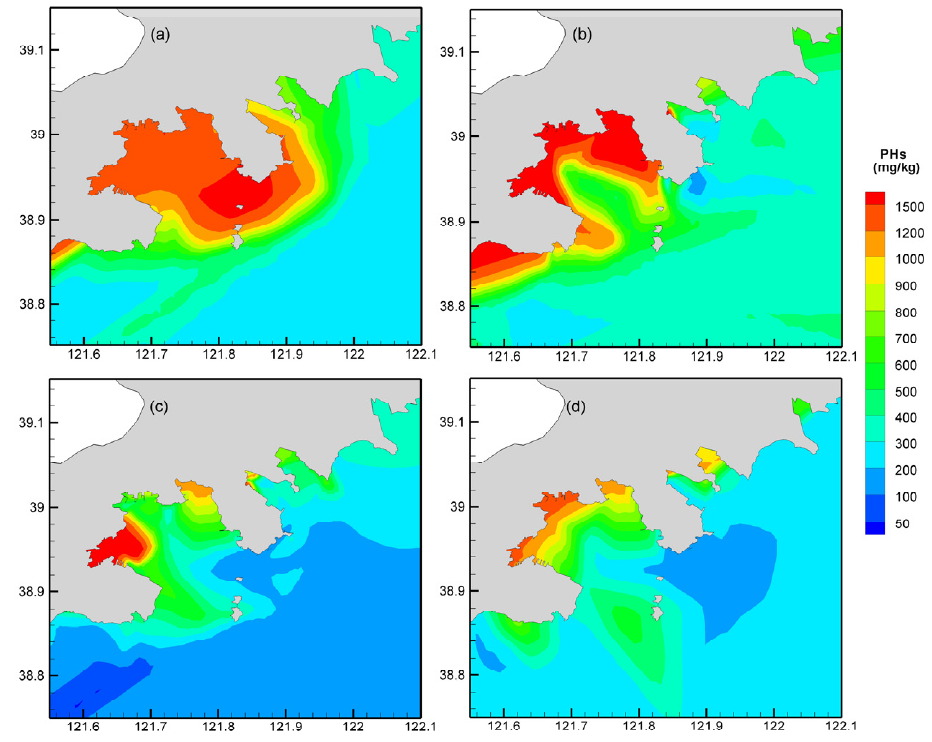
Figure 2. Spatial distribution of TPH in seawater in different years, ( a ) September 2010, ( b ) September 2015, ( c ) December 2010, and ( d ) September 2021.